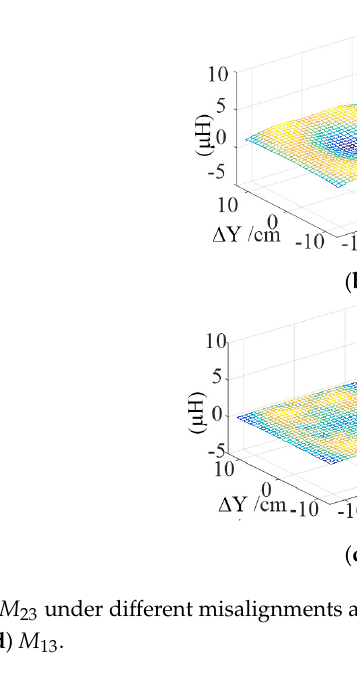
Figure 8. Simulated M 13 and M 23 versus N C2 ( ∆ X = ∆ Y = 0 and ∆ Z = 13 cm).